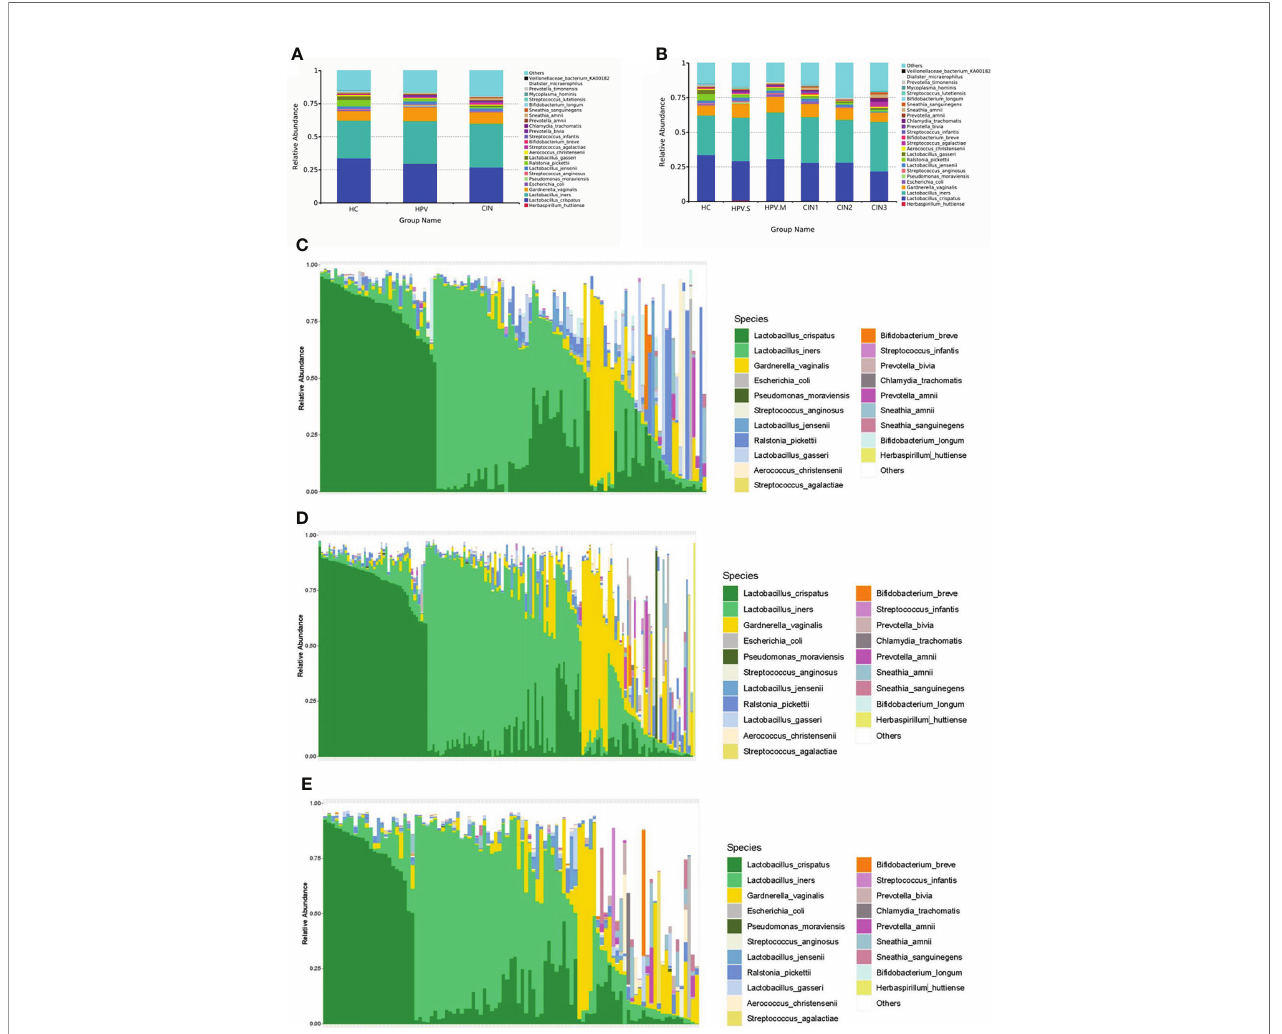
FIGURE 2 | Histogram of relative abundance of species. (A) Vaginal microbiota at the species level in HC, HPV, and CIN groups. (B) Vaginal microbiota at the species level in HC, HPV-S, HPV-M, CIN1, CIN2, and CIN3 groups. (C) Vaginal microbiota at the species level from healthy control group women. (D) Vaginal microbiota at the species level from HPV-infected group women. (E) Vaginal microbiota at the species level from CIN group